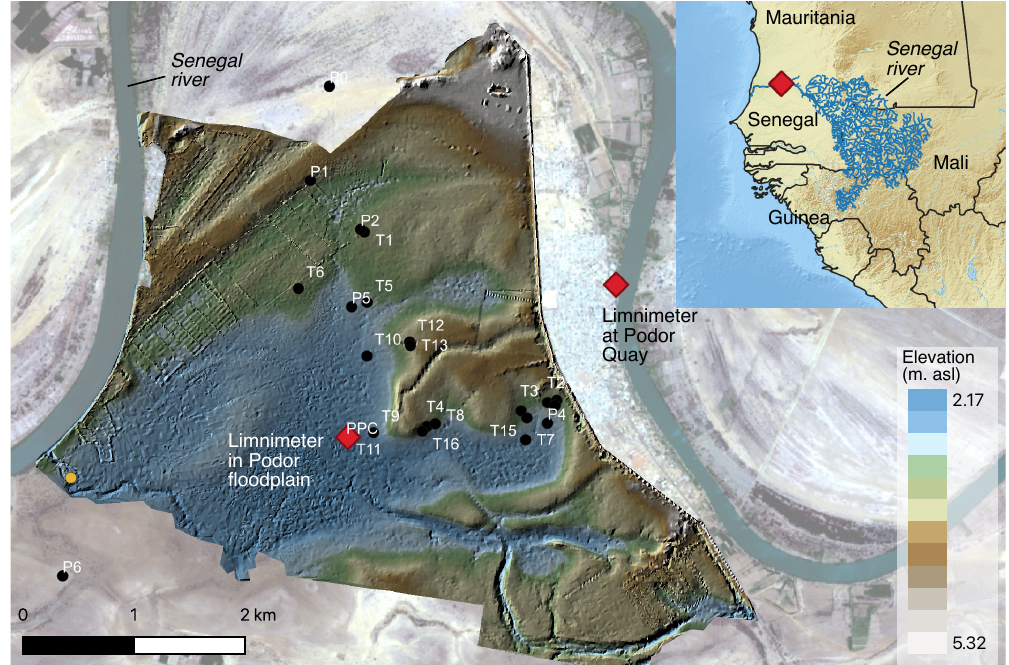
Figure 1. Sentinel-2 image of the Podor basin in the Senegal River floodplain with the high resolution digital terrain model and location of limnimeters (red) and of 22 RTK GPS sample